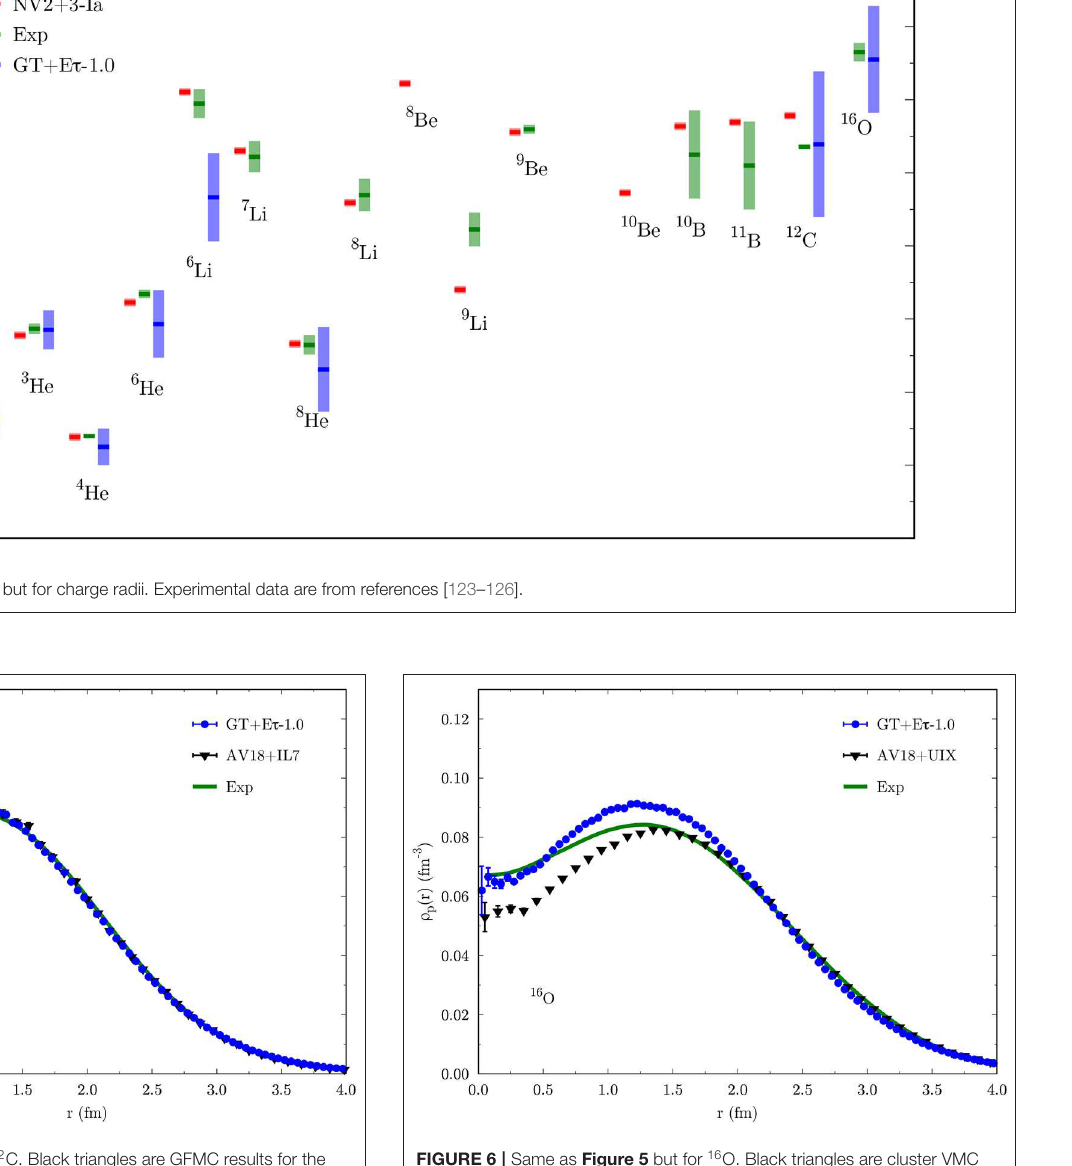
FIGURE 6 | Same as Figure 5 but for 16 O. Black triangles are cluster VMC results for the AV18+UIX potential [100]. Blue dots are AFDMC results for the GT+E τ -1.0 interaction